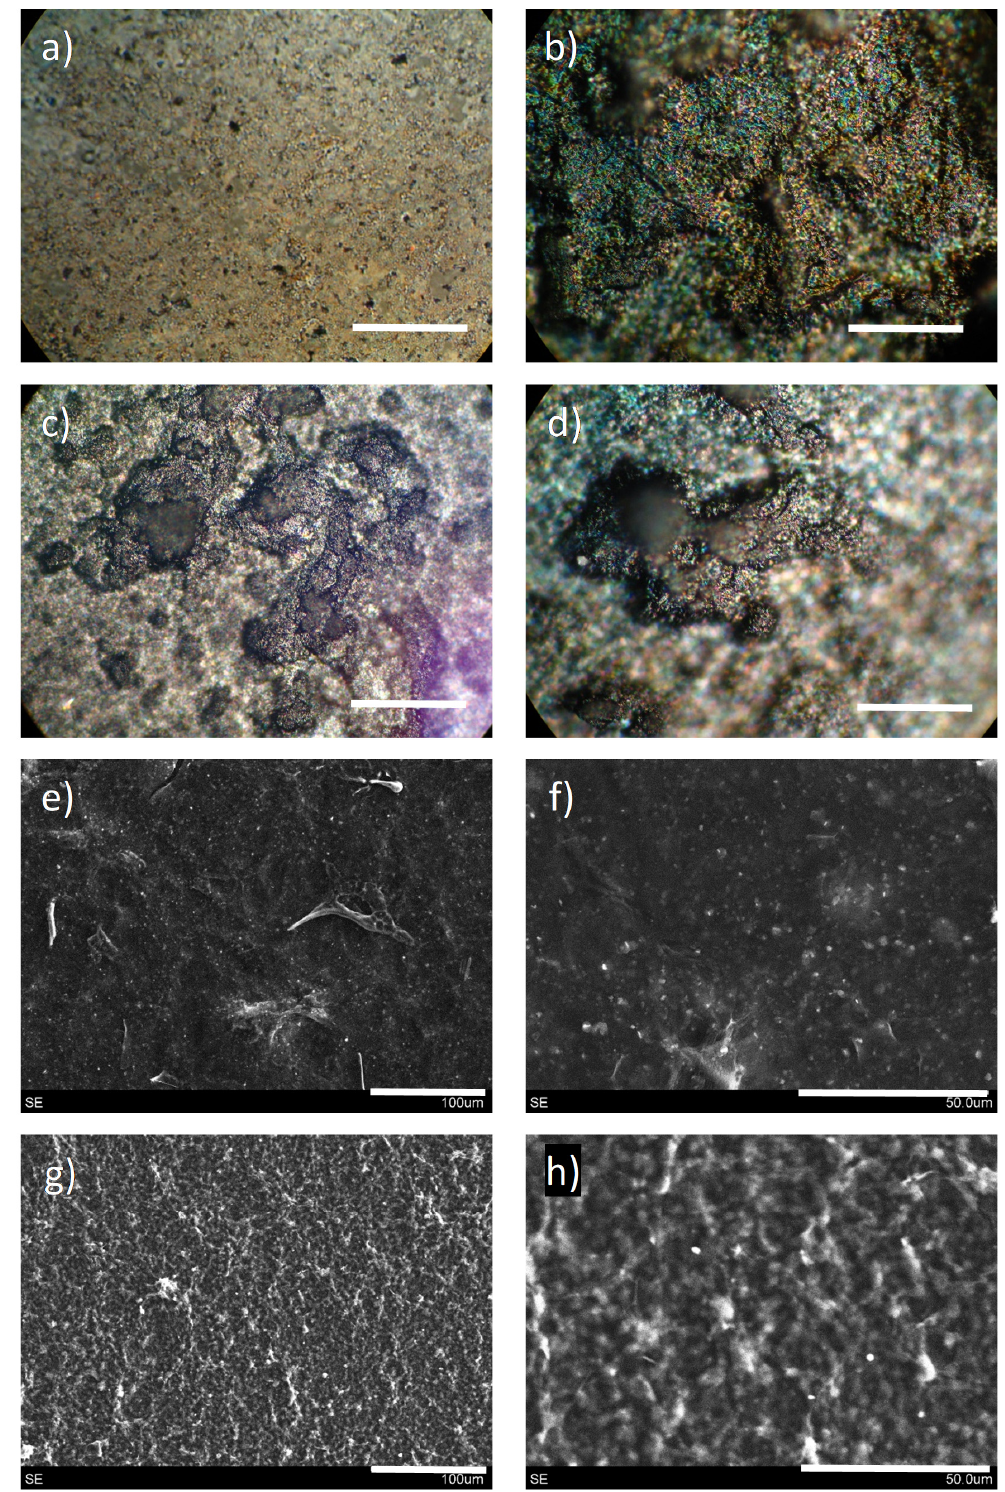
Figure 5. Optical photographs ( a – d ) and SEM images ( e – h ) of films obtained with low-viscosity inks ( a , b , e , f ) and high- viscosity pastes ( c , d , g , h ). Scale bars (in white) = 1 mm ( a , b ), 400 µ m ( c , d ), 100 µ m ( e , g ) and 50 µ m ( f , h ). Each image (either optical or from SEM) corresponds to a random point of each sample, none is the direct magnification of another.